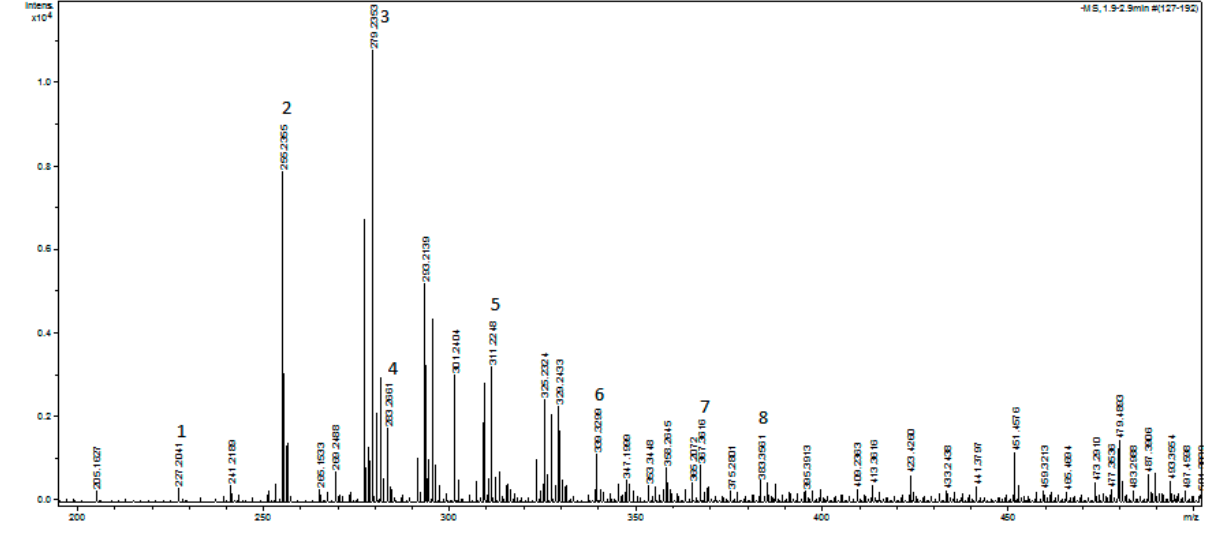
Figure 2. Micro-TOF profile of lipids extracted from C. europaea. Table 1. Compounds revealed in lipids extract of C. europaea.